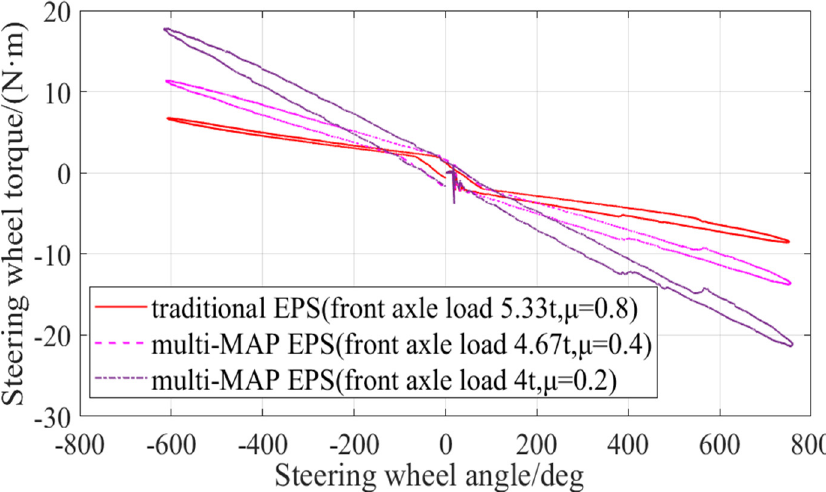
Figure 6. Steering wheel torque versus steering wheel angle.